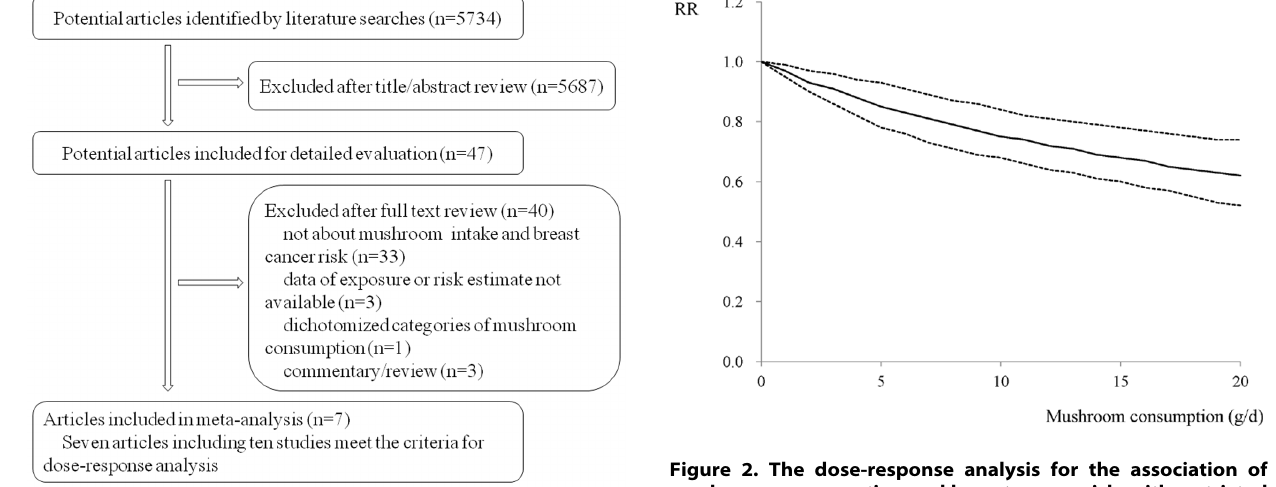
Figure 1. Flow chart of articles’ selection.